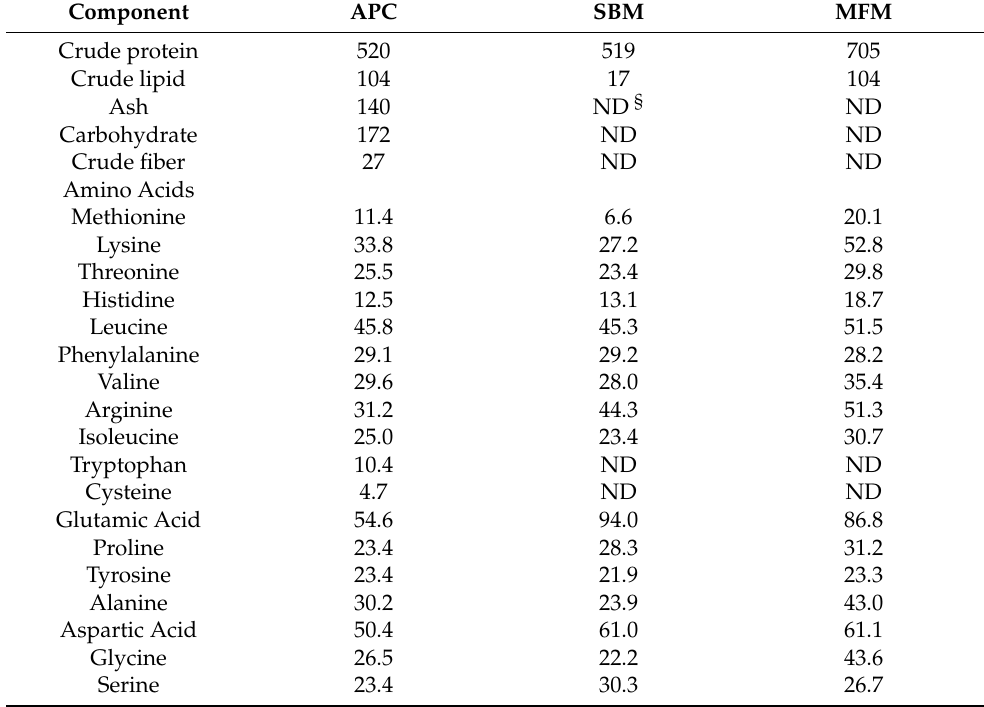
Table 1. Composition (g/kg) of alfalfa protein concentrate (APC), soybean meal (SBM), and Men- haden fishmeal (MFM). Component APC SBM MFM Crude protein 520 Crude lipid